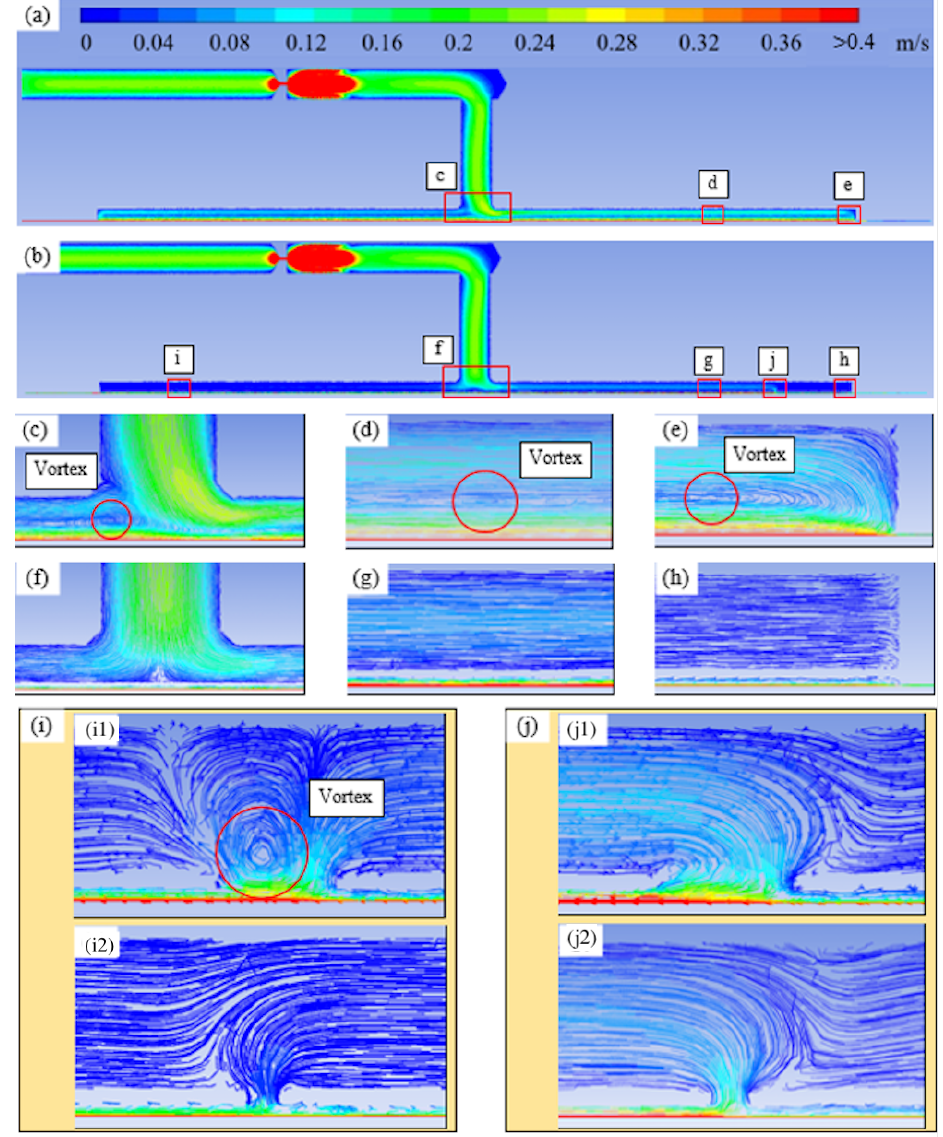
Figure 15. Velocity flow pattern of the bearings at moving speed of 0.4 m/s. ( a ) Bearing recess without improvement. ( b ) Bearing recess with double-slit septum. ( c , f ) Recess inlet position. ( d , g ) Random local region. ( e , h ) Recess edge region. ( i , j ) Slit regions. ( i1 , j1 ) Slits with 1 mm width. ( i2 , j2 ) Slits with 0.3 mm